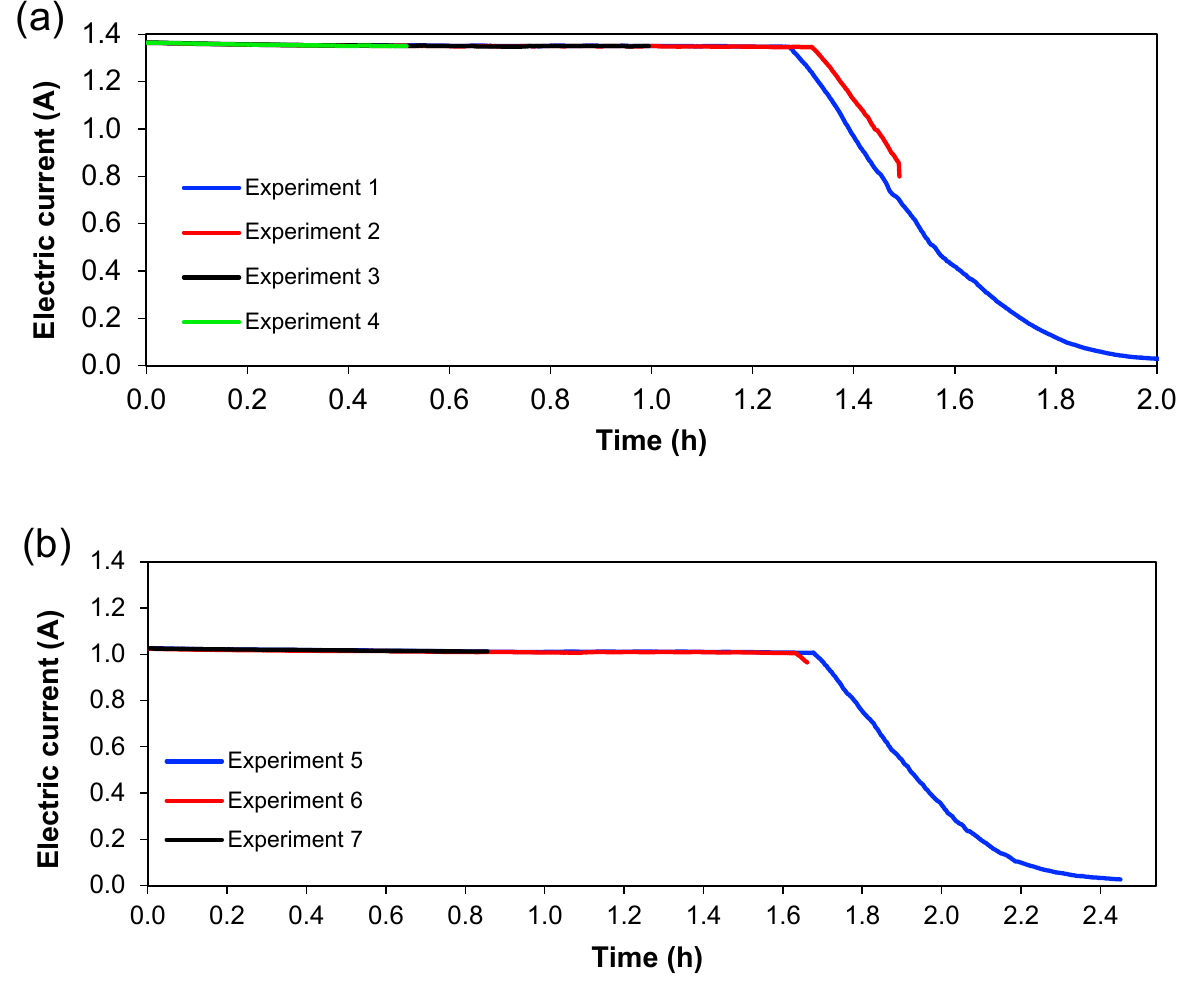
Figure 6. Development of the electric current with time. ( a ) Series 1, ( b ) Series 2.